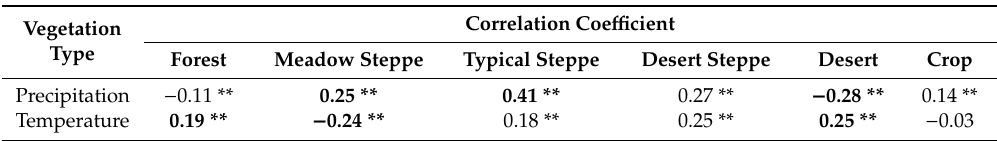
Table 5. Correlations between the CVs of growing season NDVI and those of climate variables during March-September for di ff erent biomes in Inner Mongolia from 1982 to